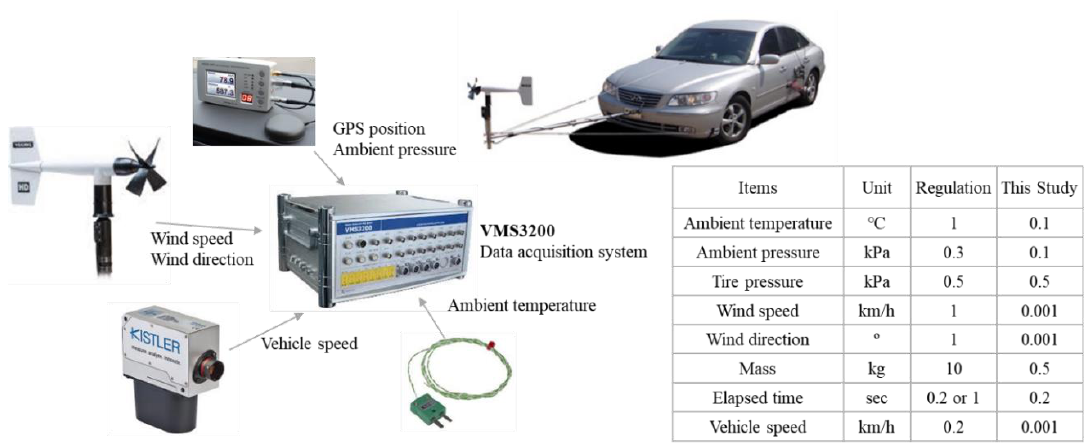
Figure 4. Coastdown test measurement system and its accuracy .